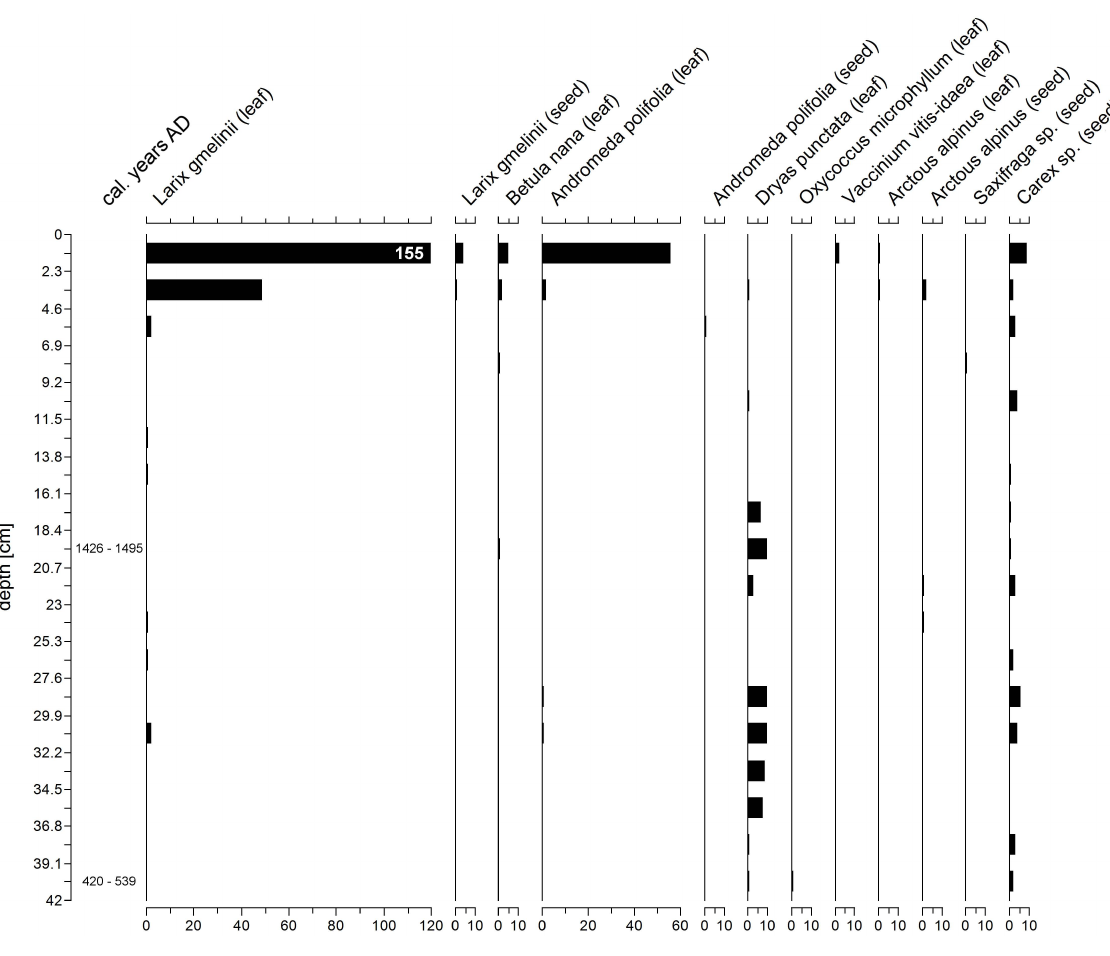
Fig. A5. Results of the macrofossil analysis for Section